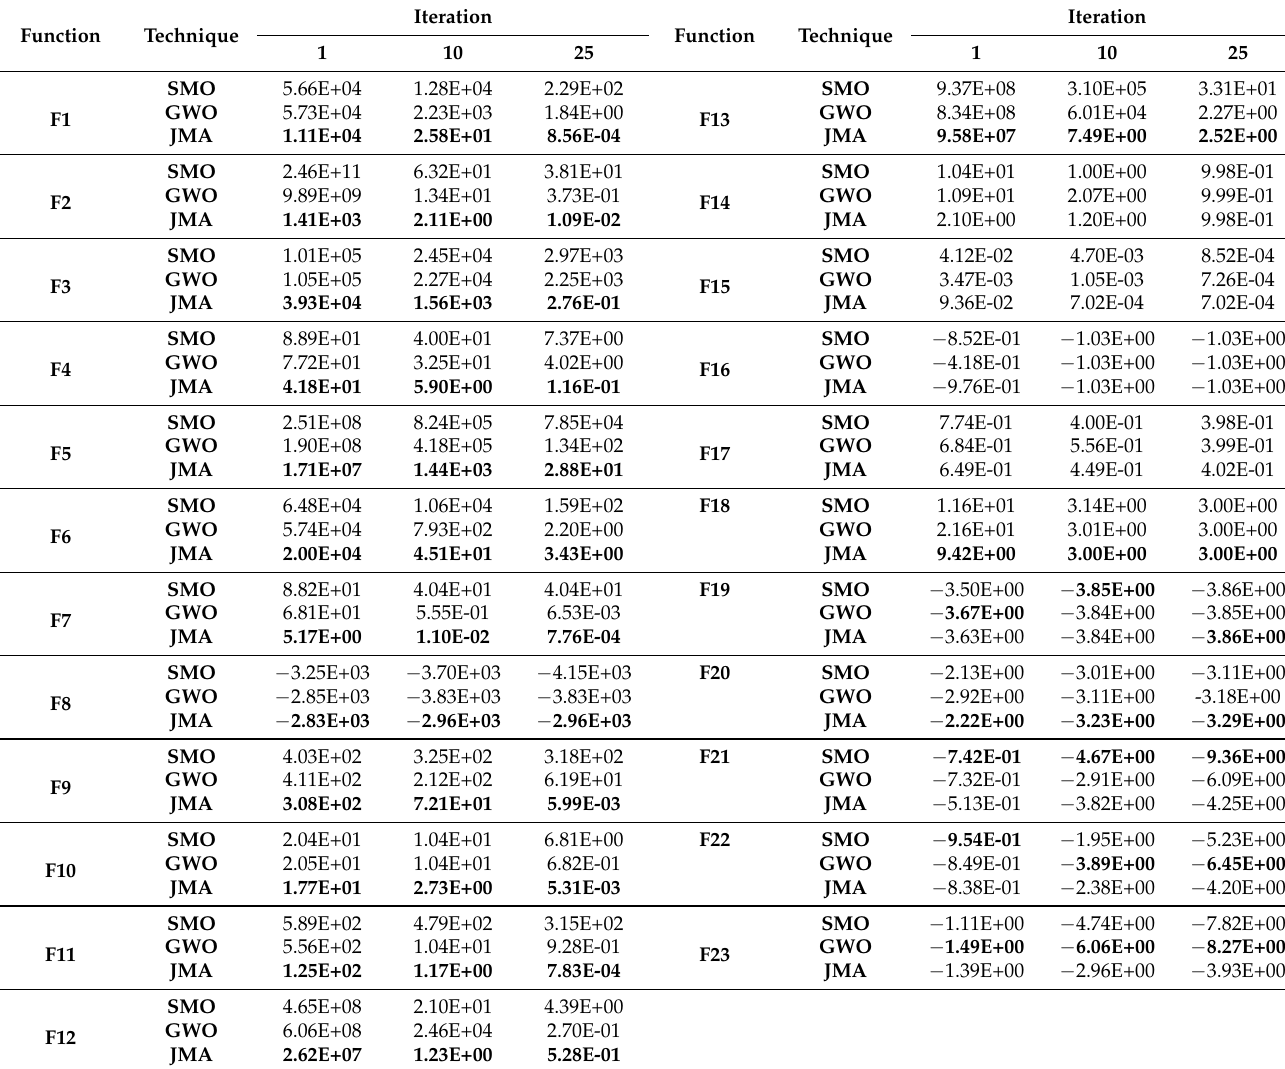
Table 8. Best values obtained by JMA, GWO and SMO in Iterations 1, 10, and 25. Iteration Function Technique Function